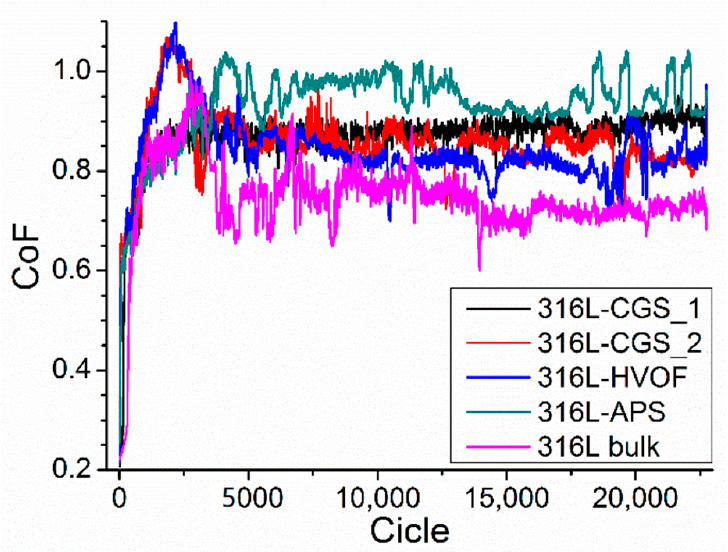
Figure 9. Results of ball-on-disk testing for 316L coatings and bulk.